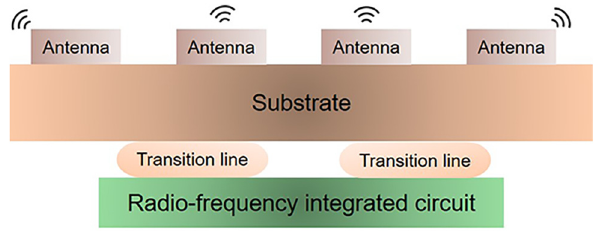
Figure 2: Schematic diagram of integrating 5G antennas for millimeter wave spectrum bands. The antenna arrays are placed on the substrate, and the radio frequency - integrated circuit is located on the opposite side of the